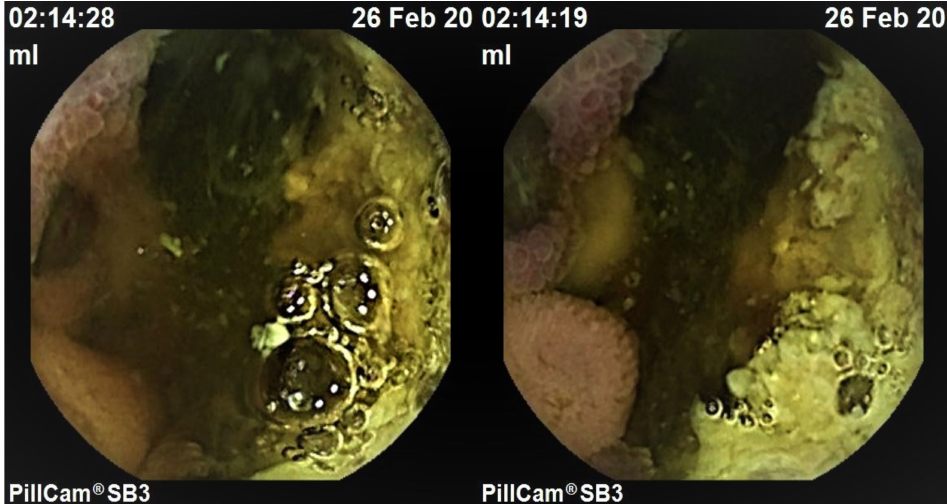
Figure 1. VCE appearance of characteristic coal-black central depression surrounded by exophytic whitish area emblematic of metastatic melanoma in the small